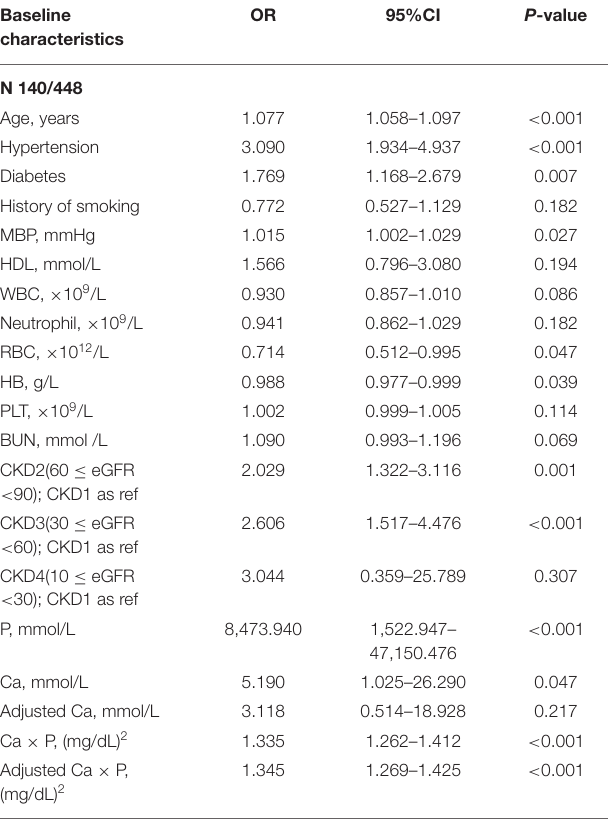
TABLE 2 | Univariate analysis for factors associated with CSVD by binary